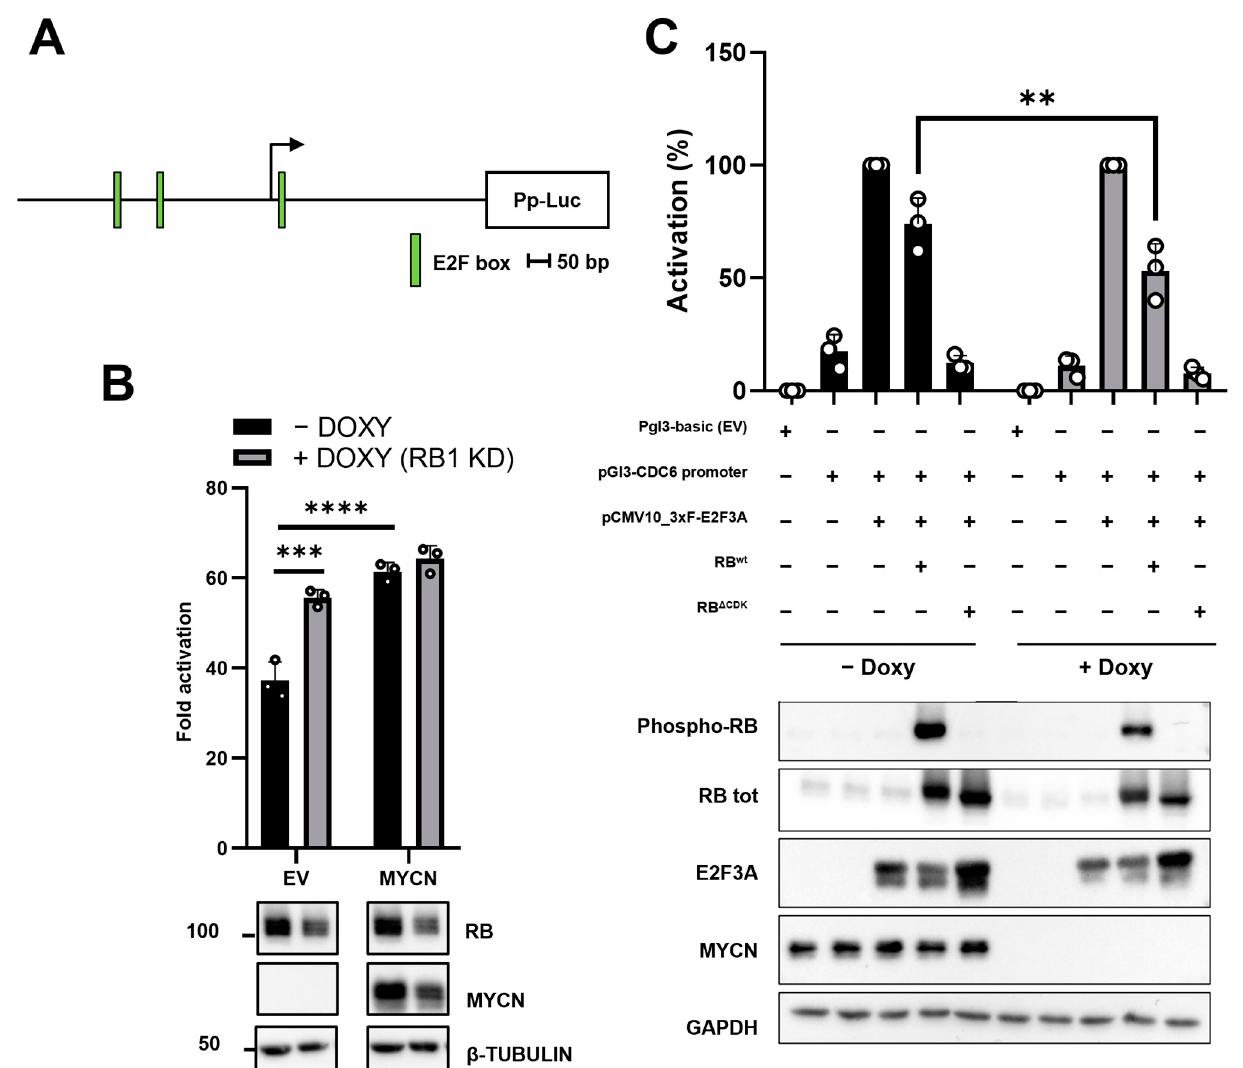
Figure 2. MYCN overcomes RB function in SK-N-AS and TET21/N cell lines. ( A ) Schematic illustration of the CDC6 promoter region. E2F consensus boxes are highlighted in green. Pp: Photinus pyralis luciferase; bp: base pairs ( B ) Up: dual luciferase assay in SK-N-AS cKD RB1 cell line. Cells were incubated with or without doxycycline for 48 hours to induce RB1 downregulation, then were transfected with pGL3b, pGL3b_CDC6 + EV, or pGL3b_CDC6 + MYCN. Constitutive promoter-driven Renilla reniformis (Rr) luciferase was used as internal control for transfection efficiency. Fold activation values represent Pp/Rr luciferase activity relative to the pGL3b alone condition. Down: western blot of the same cells transfected with the indicated construct. β -tubulin was used as loading control ( C ) Up: dual luciferase assay in the TET21/N cell line. Cells were incubated with or without doxycycline for 48 hours to induce MYCN downregulation, then were transfected as shown. Constitutive promoter-driven Rr luciferase was used as internal control. RB tot = total RB. Activation (%) values represent Pp/Rr luciferase activity relative to pGL3b_CDC6 + E2F3A sample. Down: western blot of the same cells transfected as indicated. GAPDH was used as loading control. Luciferase experiments results were shown as an average of three (N = 3) independent experiments ±SD. **, ***, **** indicated p < 0.01, 0.001, and 0.0001, respectively. Statistical analyses were performed with two-way ANOVA.